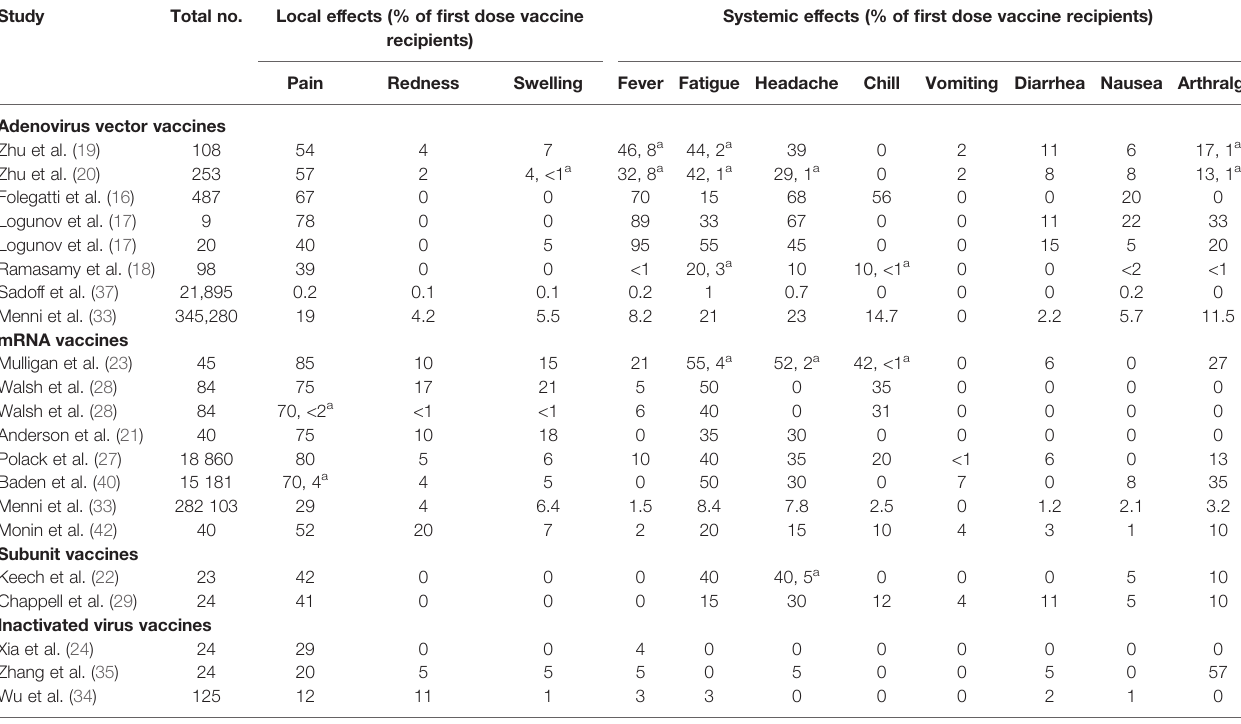
TABLE 4 | Published trials and observational studies showing side effects of the COVID-19 vaccines included in this systematic review. Study Total